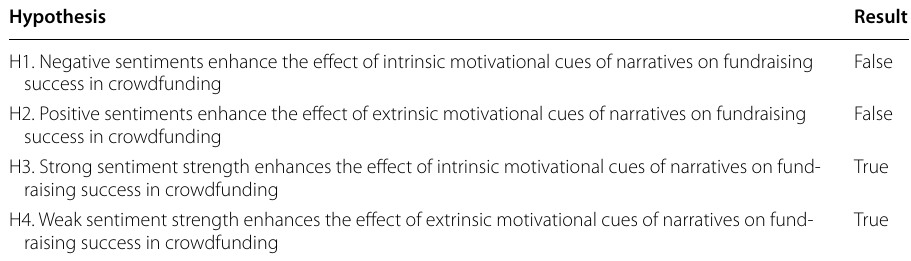
Table 11 Results of hypothesis Hypothesis